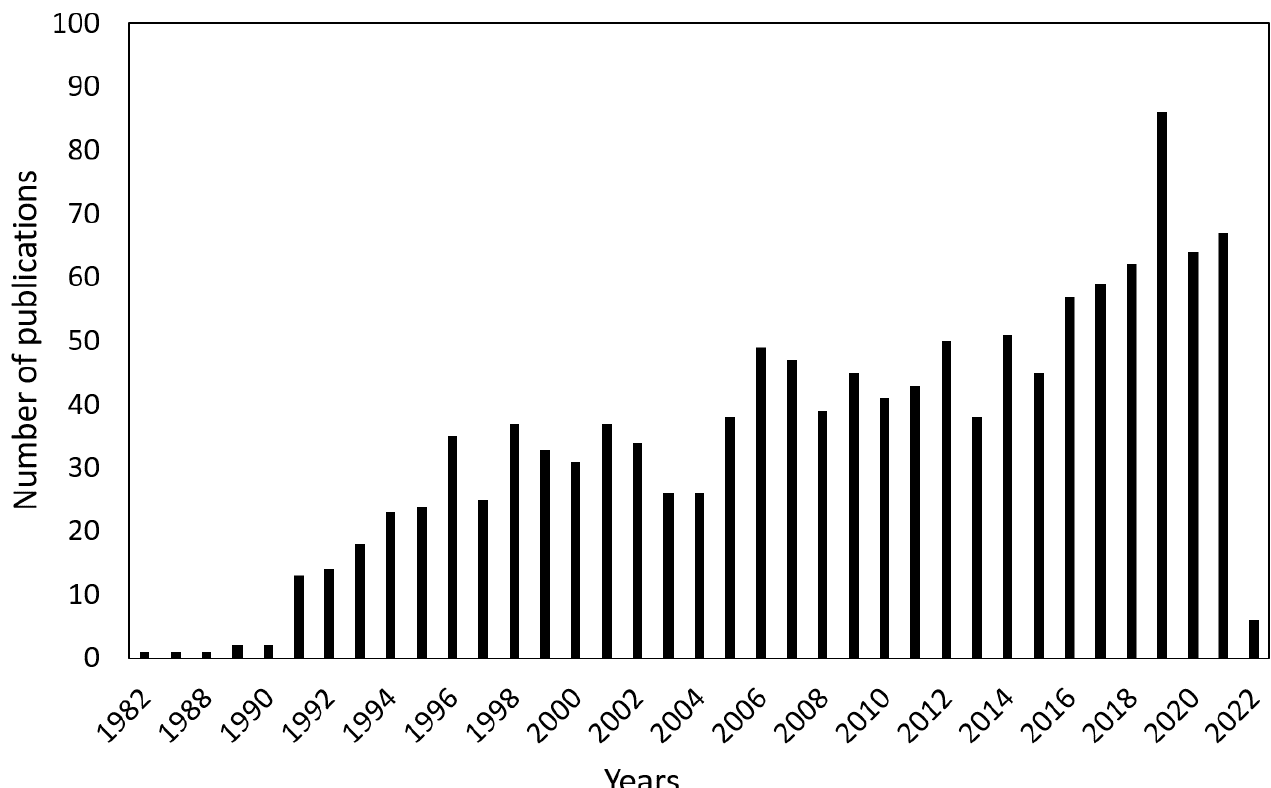
Figure 2. The publication trend on fractal theory in thin film materials for the period 1982–2022 according to Web of Science database.